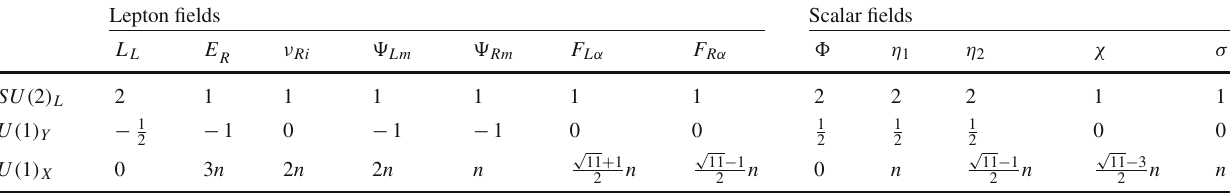
Table 1 Contents of relevant particle fields. We have set i = 1 , 2; m = 1 − 9 and α = 1 − 4 to satisfy the anomaly free condition Lepton